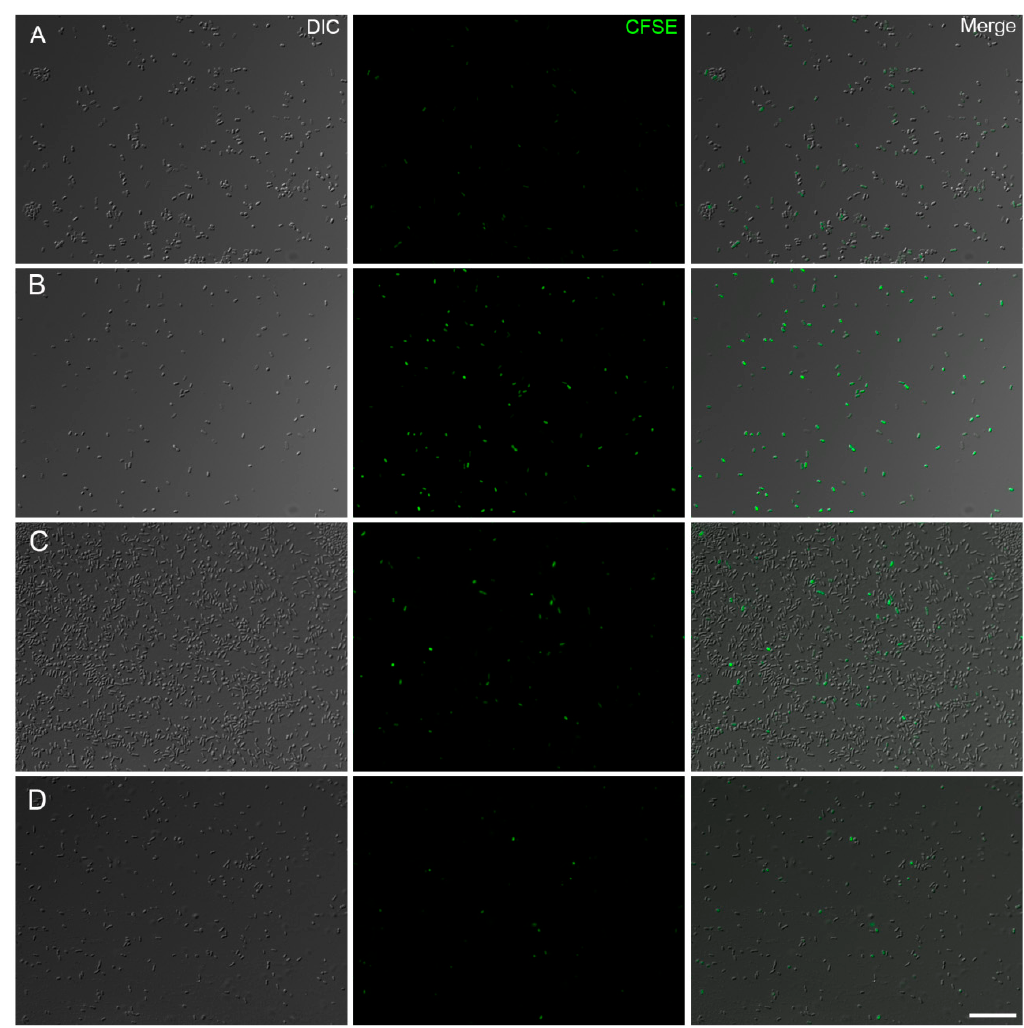
Figure 3. Fluorescence images of CFSE stained A. baumannii after treatment with melittin (142 µg/mL) for 2 h at 37 °C. The proliferation of untreated bacteria ( A ) and bacteriostatic effect of melittin against ATCC strain ( B ). A. baumannii PDR strain 100 images of CFSE-labeled bacteria from untreated ( C ) and melittin treated cells ( D ). DIC: Differential interference contrast. Bar = 20 µm.